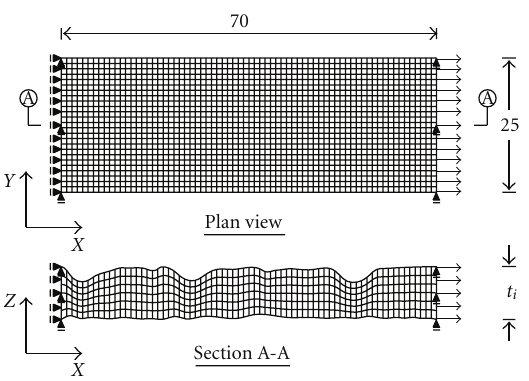
Figure 4: Analytical model of corroded